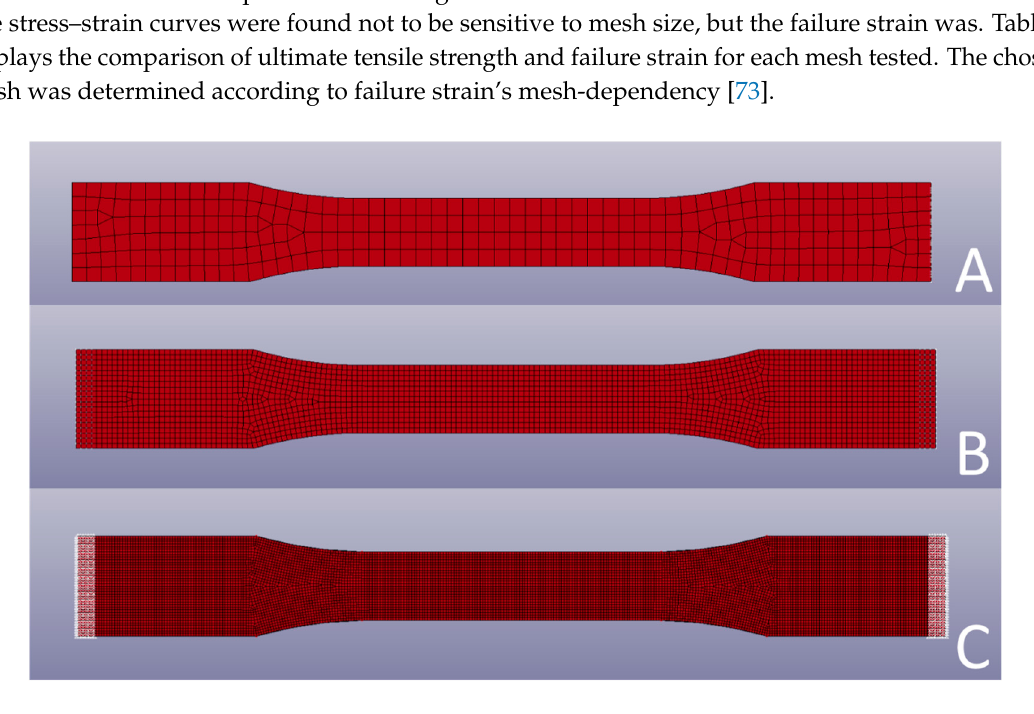
Table 3. Mesh Variability Results.